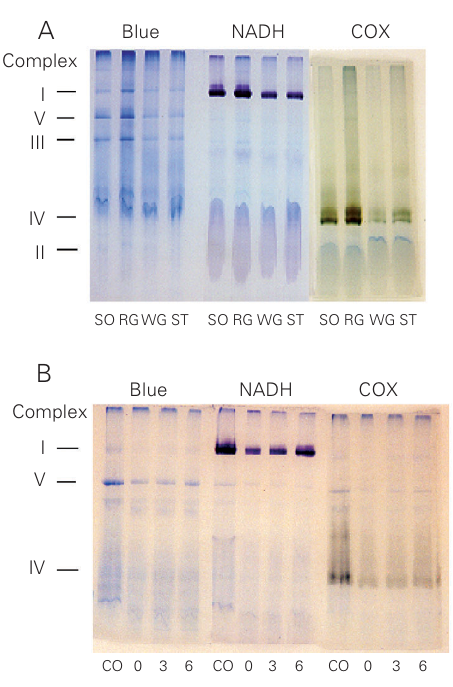
Figure 1. A , Colorimetric enzy- matic staining on BN-PAGE gels of different rat muscle